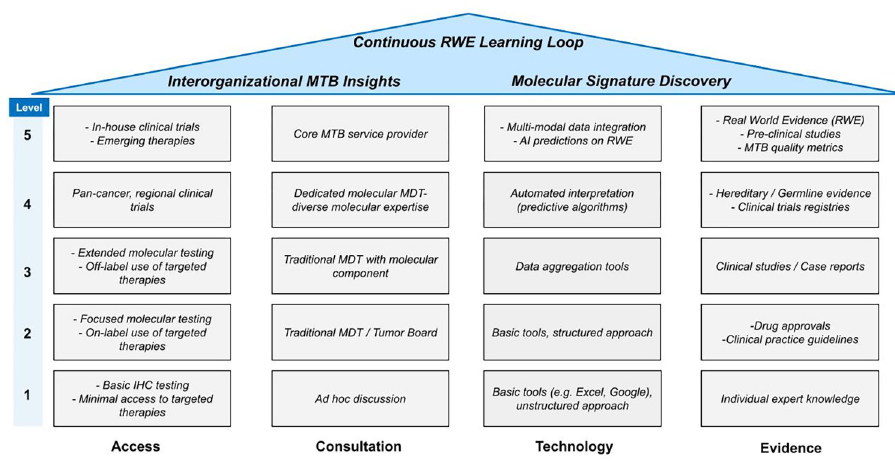
Fig 1. The ACTE-MTB maturity model. MTB : Molecular Tumor Board; IHC : Immunohistochemistry; MDT : Multi- Disciplinary Team; RWE : Real World Evidence.